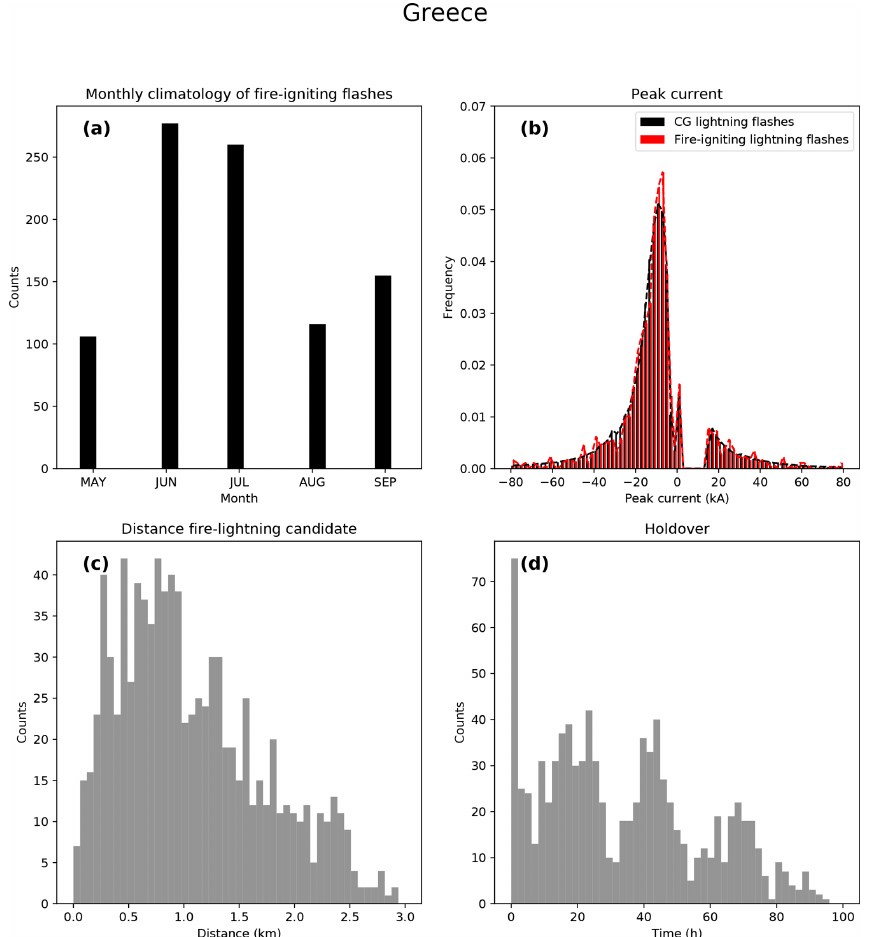
Figure 4. Analysis of fire-igniting flashes in Greece between 2017 and 2019. (a) Monthly distribution of the occurrence of LIWs. (b) Frequency distribution of the peak currents of all CG lightning taking place over coniferous and mixed forest during May and September (black) and of all fire-igniting lightning flashes (red) detected with ENTLN. (c) Distribution of the distance between the reported position of ignition and the lightning candidate. (d) Distribution of the